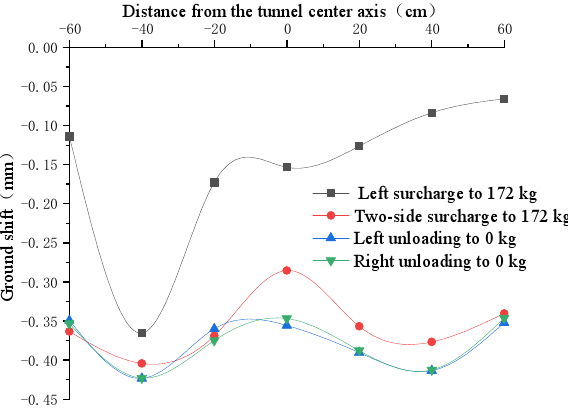
Figure 19. Variation in ground shift under different surcharges for Case 4.